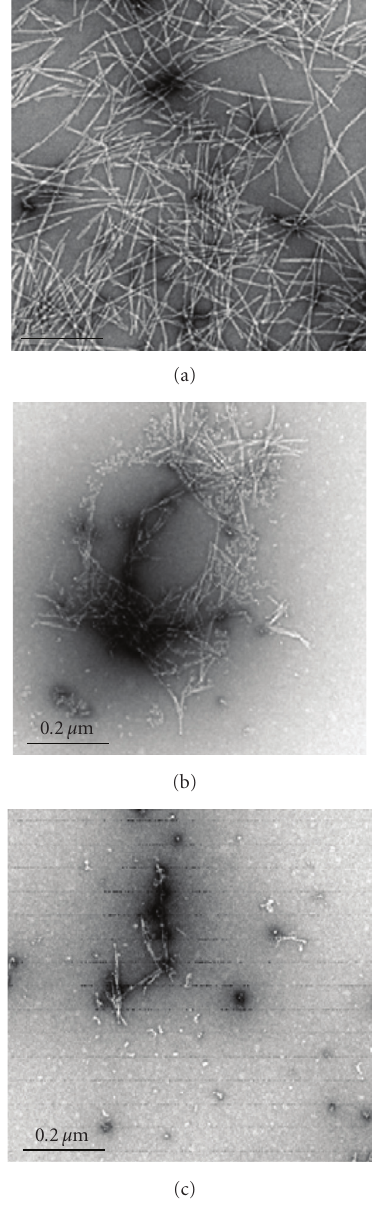
Figure 6: TEM images of α -synuclein samples after 3 days of incubation in the absence (a) and presence of weak/good (b) and strong (c) inhibitors of α -synuclein